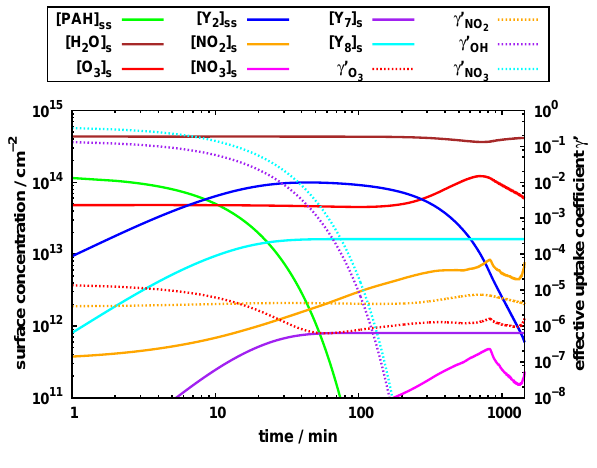
Fig. 3. Evolution of surface species concentrations and effective uptake coefficients during the simulated 24h period on an individual particle emitted at 06:00a.m. in scenario A. Note the logarithmic time